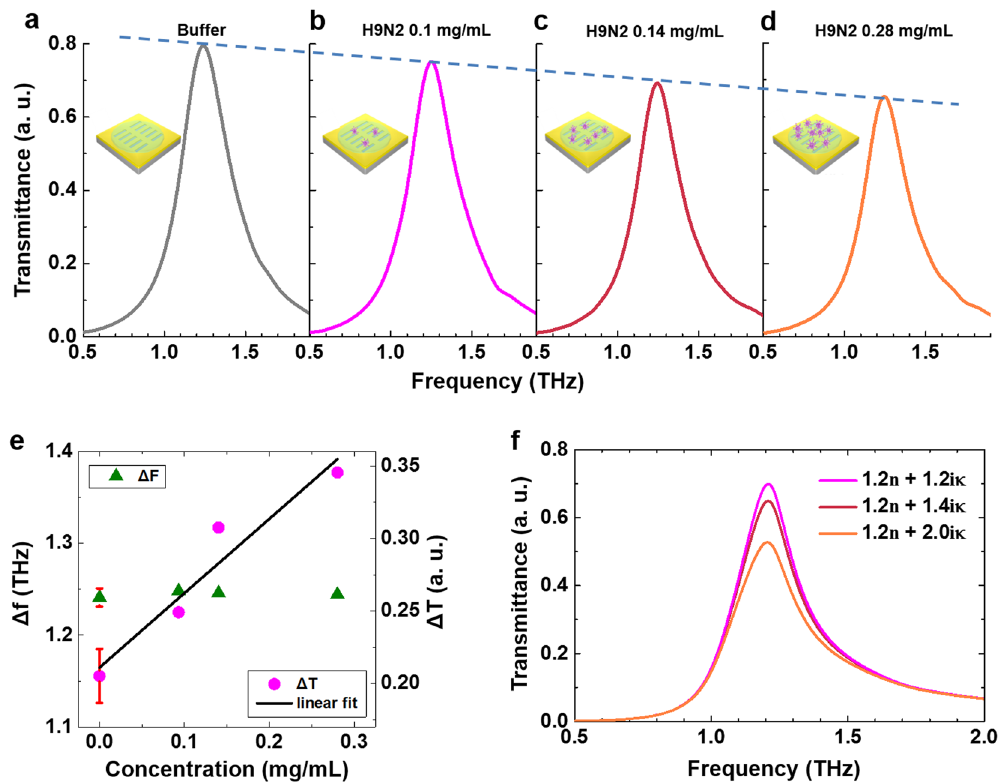
Figure 3. Virus quantification by nano-metamaterial based THz detection. ( a – d ) Normalized THz spectra for various concentrations (0, 1, 0.14, 0.28 mg/ml) of H9N2 virus in the buffer solution. ( e ) The changes in the maximum values of the normalized transmittances ( Δ T , magenta closed circle) and shifted resonance frequency ( Δ f , green closed triangle) are plotted for H9N2 virus in different concentrations as a function of concentration level. The red bar is error bar of buffer solution measurement. Black line and gray dashed line are linear fitting of the transmittance change and frequency shift data, respectively. ( f ) FDTD simulation results of transmittances for three different model samples with various composition of dielectric constants ( n and κ ) are